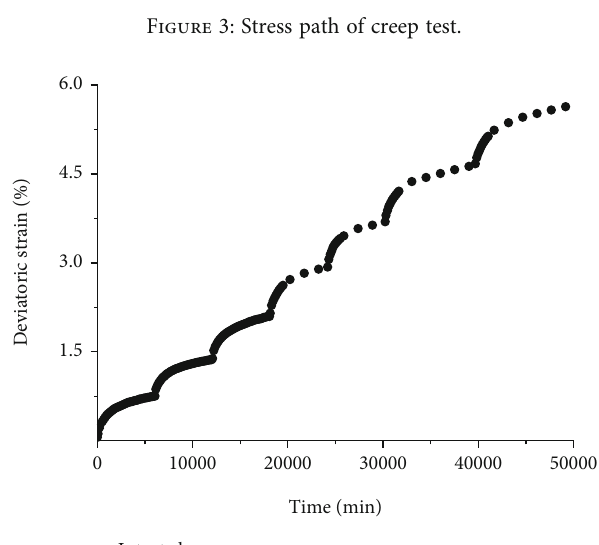
Figure 3: Stress path of creep test.